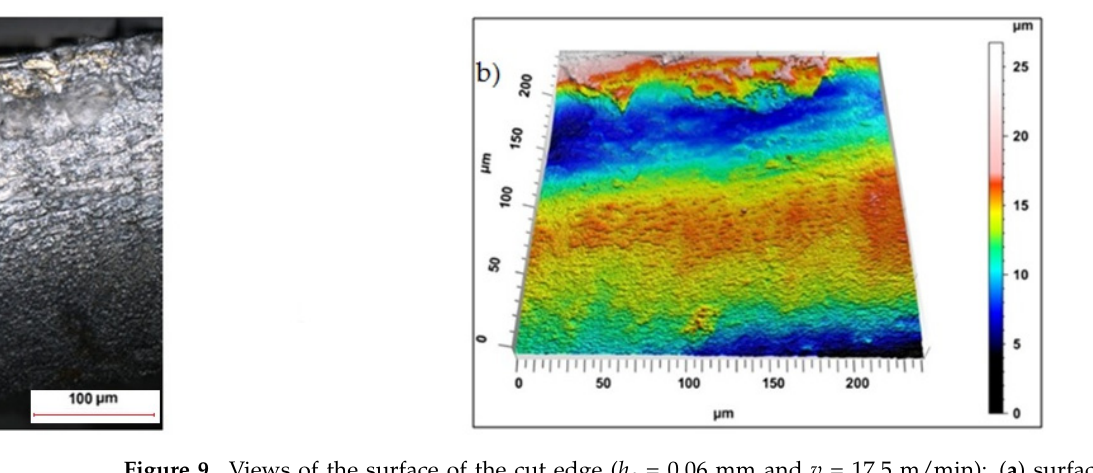
Figure 9. Views of the surface of the cut edge ( h c = 0.06 mm and v = 17.5 m/min): ( a ) surface photography, ( b ) surface topography (uncoated steel).